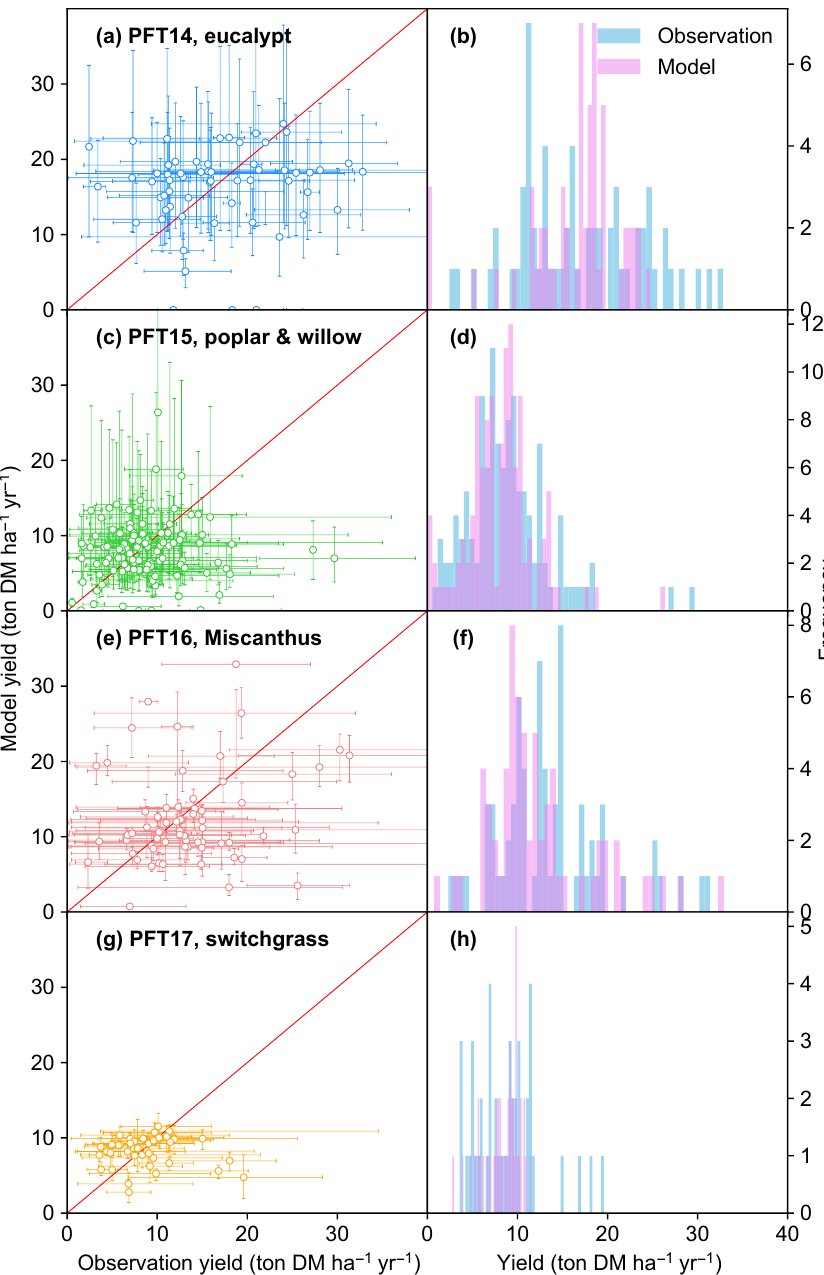
Figure 3. Biomass yields from the observations and simulated by the ORCHIDEE model. The error bars of observations in the left panel represent the range of different observations in this half-degree grid cell caused by different sites, treatments, species, and genotypes. The error bars of modeled yields represent the range of different harvest years caused by the interannual variability of climate. PFT14 is tropical bioenergy tree, eucalypt; PFT15 is temperate bioenergy tree, poplar and willow; PFT16 is C 4 bioenergy grass, Miscanthus ; PFT17 is C 4 bioenergy grass, switchgrass. The red line indicates the 1 : 1 ratio